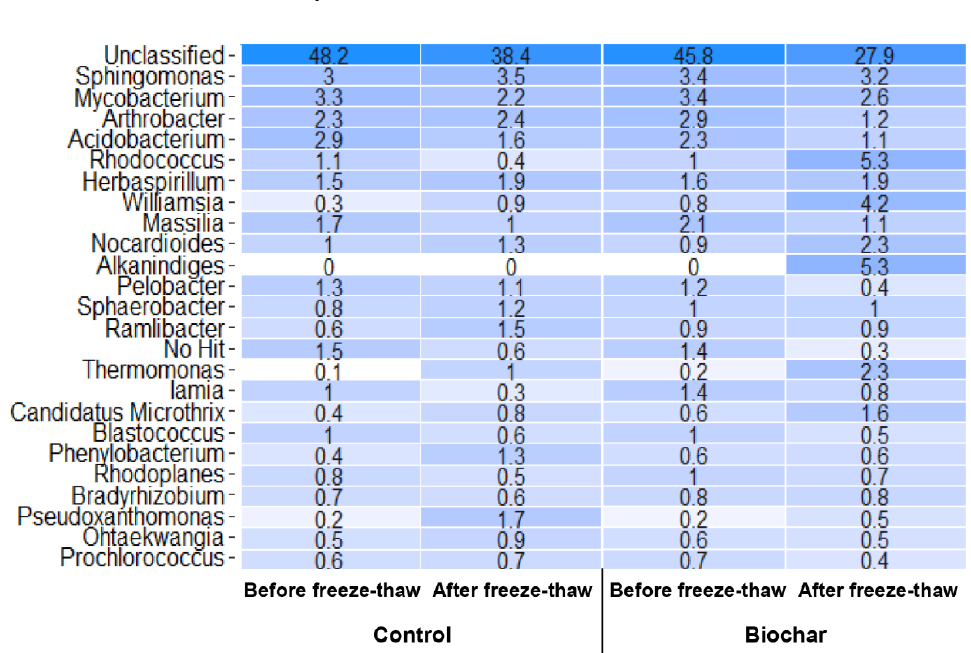
Figure 9. Heatmap of the genera with the highest percentage abundances in phytostabilized non- amended (control) and biochar-amended soil samples, respectively. Phytostabilization was carried out under the following conditions: (1) greenhouse temperatures (before freeze–thaw) and (2) greenhouse temperatures, followed by FT-chamber temperatures (after freeze–thaw).